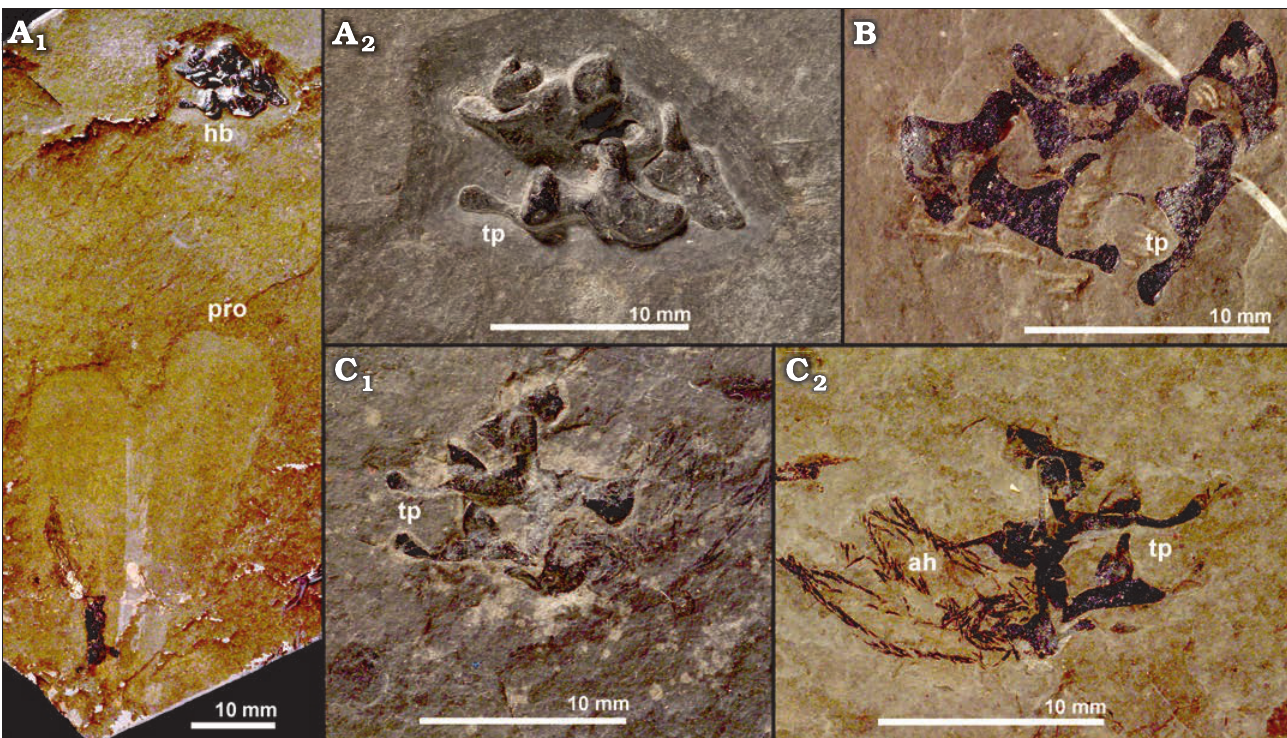
Fig. 3. Coleoid cephalopod Phragmoteuthis bisinuata (Bronn, 1859), overview of the hypothesized “beaks of P. bisinuata ”; lower Carnian, Upper Triassic, Cave del Predil, NE Italy. A . GBW 2006/011/0009, an imprint of a proostracum, ink sac and “beaks” (A 1 ), enlarged detail of the “beaks” (A 2 ). B . GBA 2006/011/0041; isolated “beaks”. C . GBW 2006/011/0001, “beaks” associated with the arm hooks (enlarged details of Fig. 2C), part (C 1 ) and counter-part (C 2 ). Abbreviations: ah, arm hook; hb, hypothesized “beaks of P. bisinuata ”; pro, proostracum; tp, “tubercle-like processes” of the hypothesized “beak of